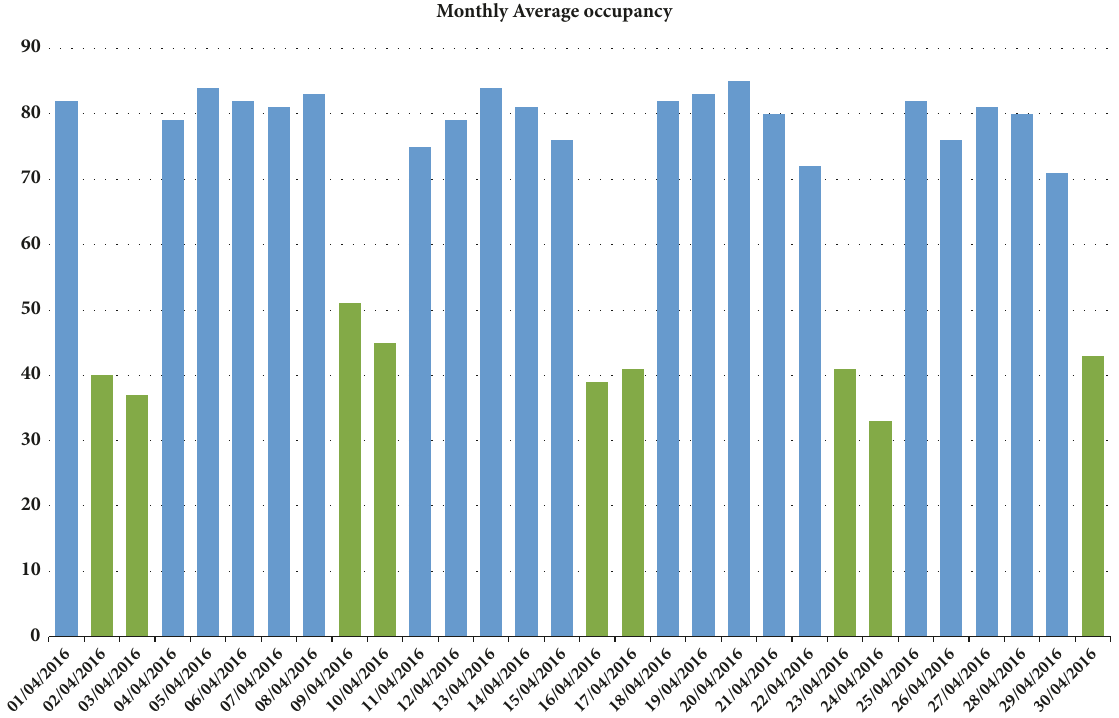
Figure 13: Parking occupancy for the whole month in outdoor